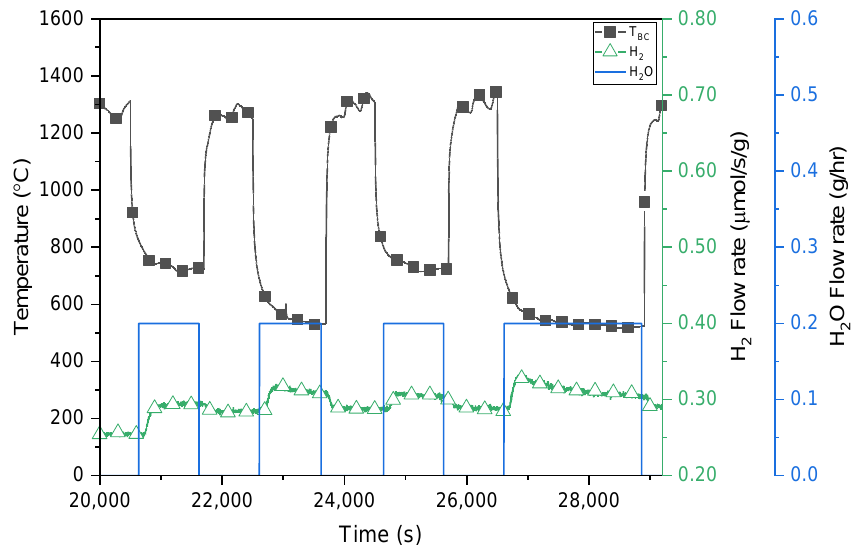
Figure 5. H 2 and H 2 O rates vs. time during 4 consecutive temperature-swing cycles with H 2 O splitting and the corresponding temperature profile of porous LSM40. Symbols are for visual purposes only.